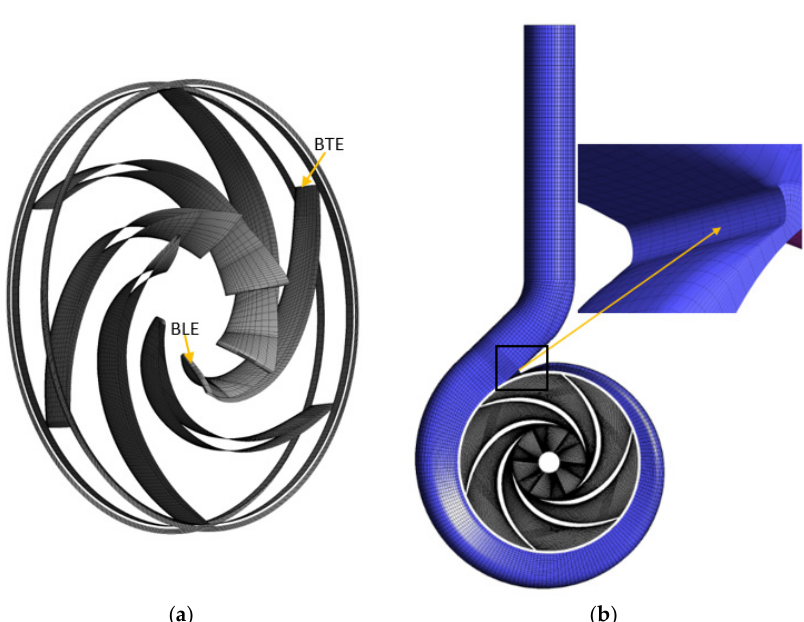
Figure 11. Mesh of ( a ) impeller blades with (BLE denoting blade leading edge and BTL denoting blade trailing edge ( b ) volute with volute tongue enlargement.